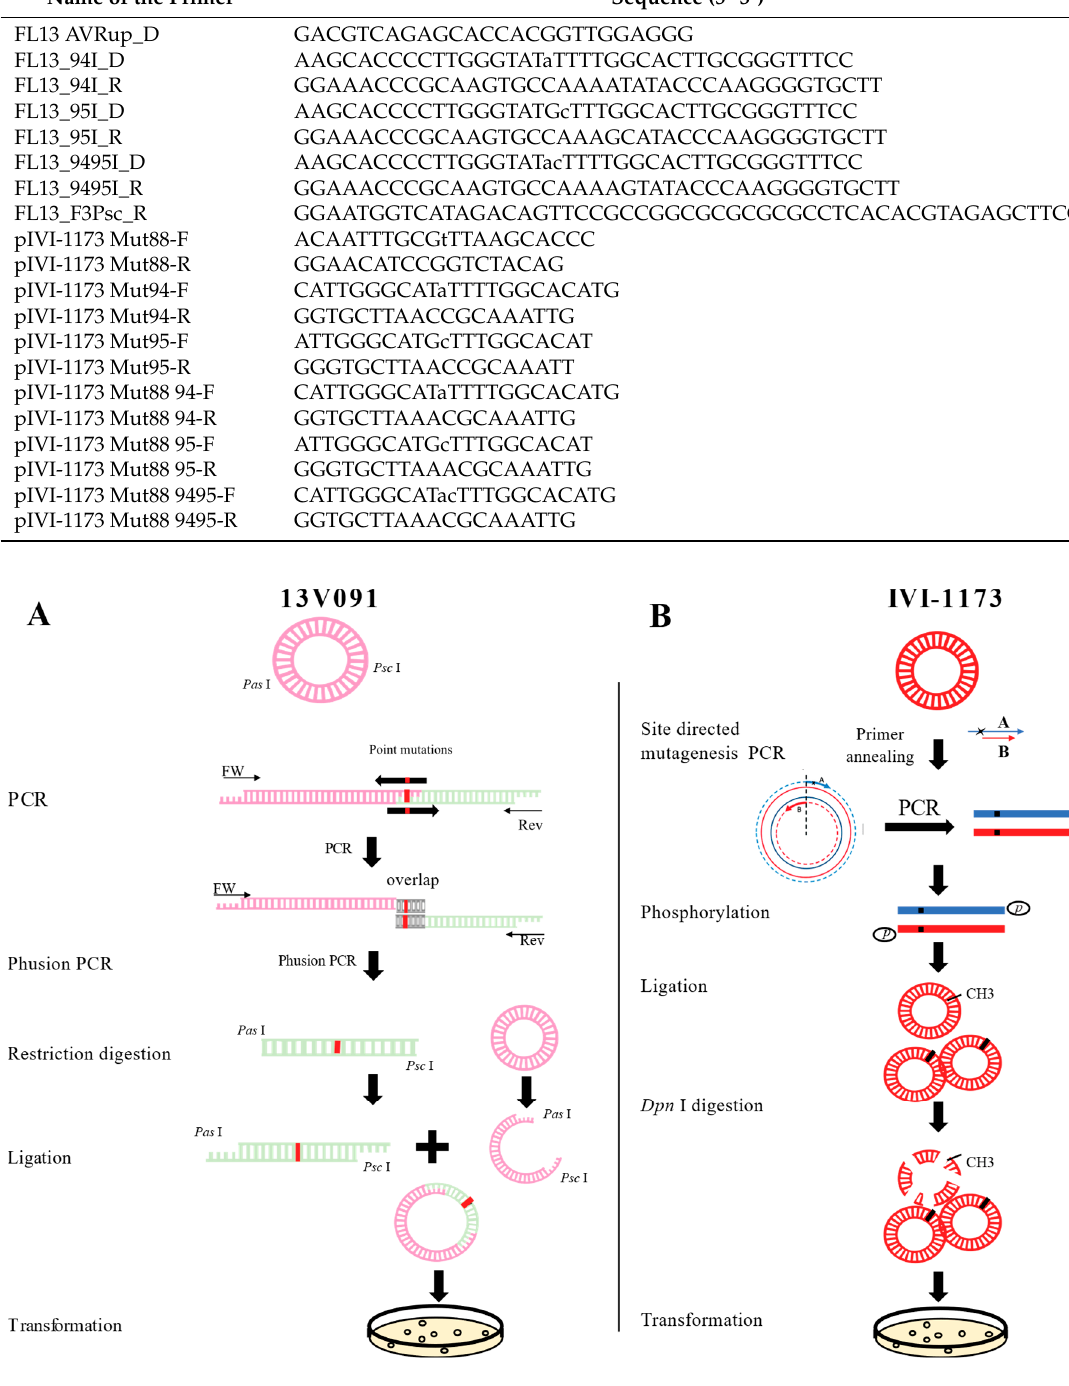
Figure 1. Mutant variants construction strategy for the infectious clone containing the full genome of the 13V091 strain ( A ) and IVI ‐ 1173 strains ( B ).